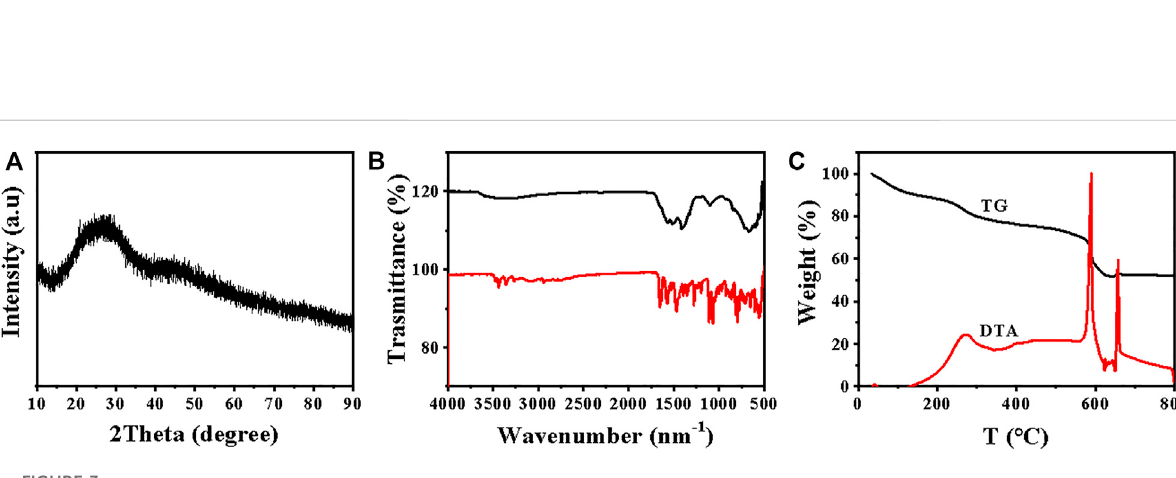
FIGURE 3 (A) XRD pattern, (B) IR spectrum and (C) TG-DTA curves of Eu-CP-Ara (Complex